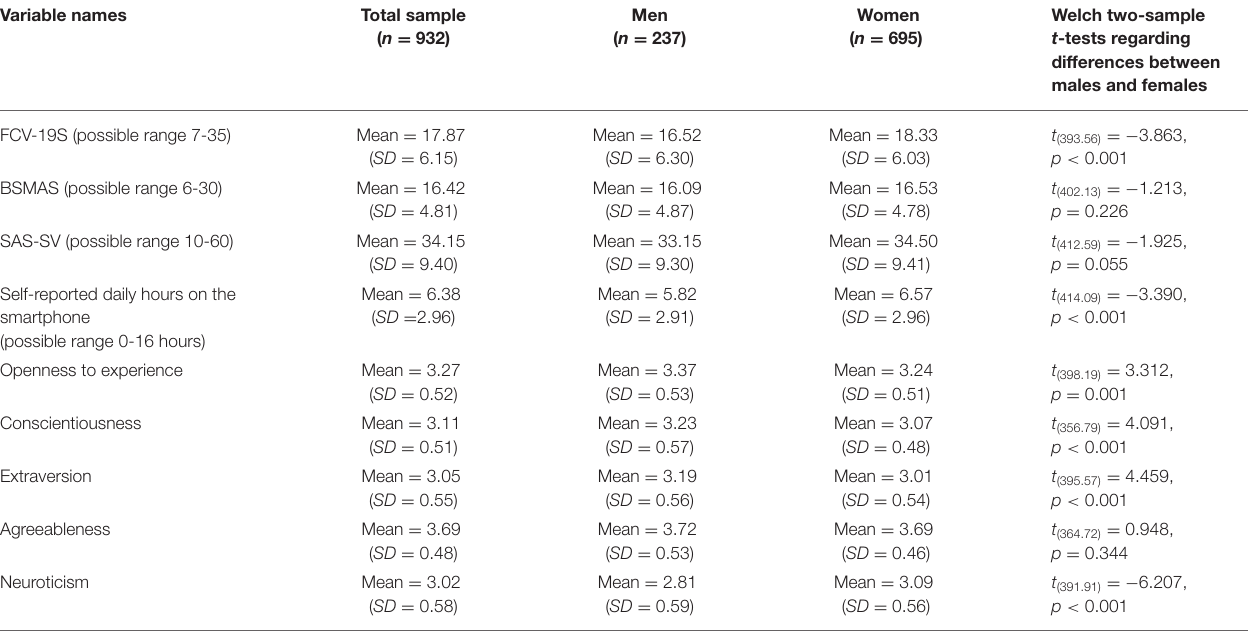
TABLE 2 | Descriptive statistics for the variables of interest in the total and in the male and female subsample separately. Variable